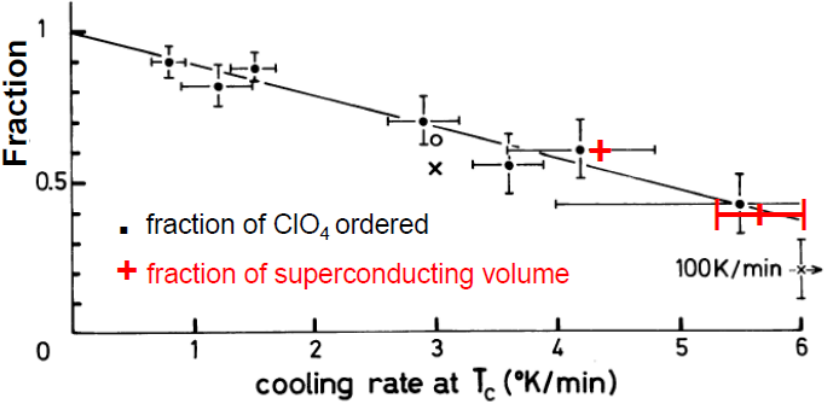
Figure 12. Fraction of ordered ClO superconducting volume (red crosses) in (TMTSF) The fraction of superconducting volume has been determined from the data of [166] assuming that the relaxed sample is completely